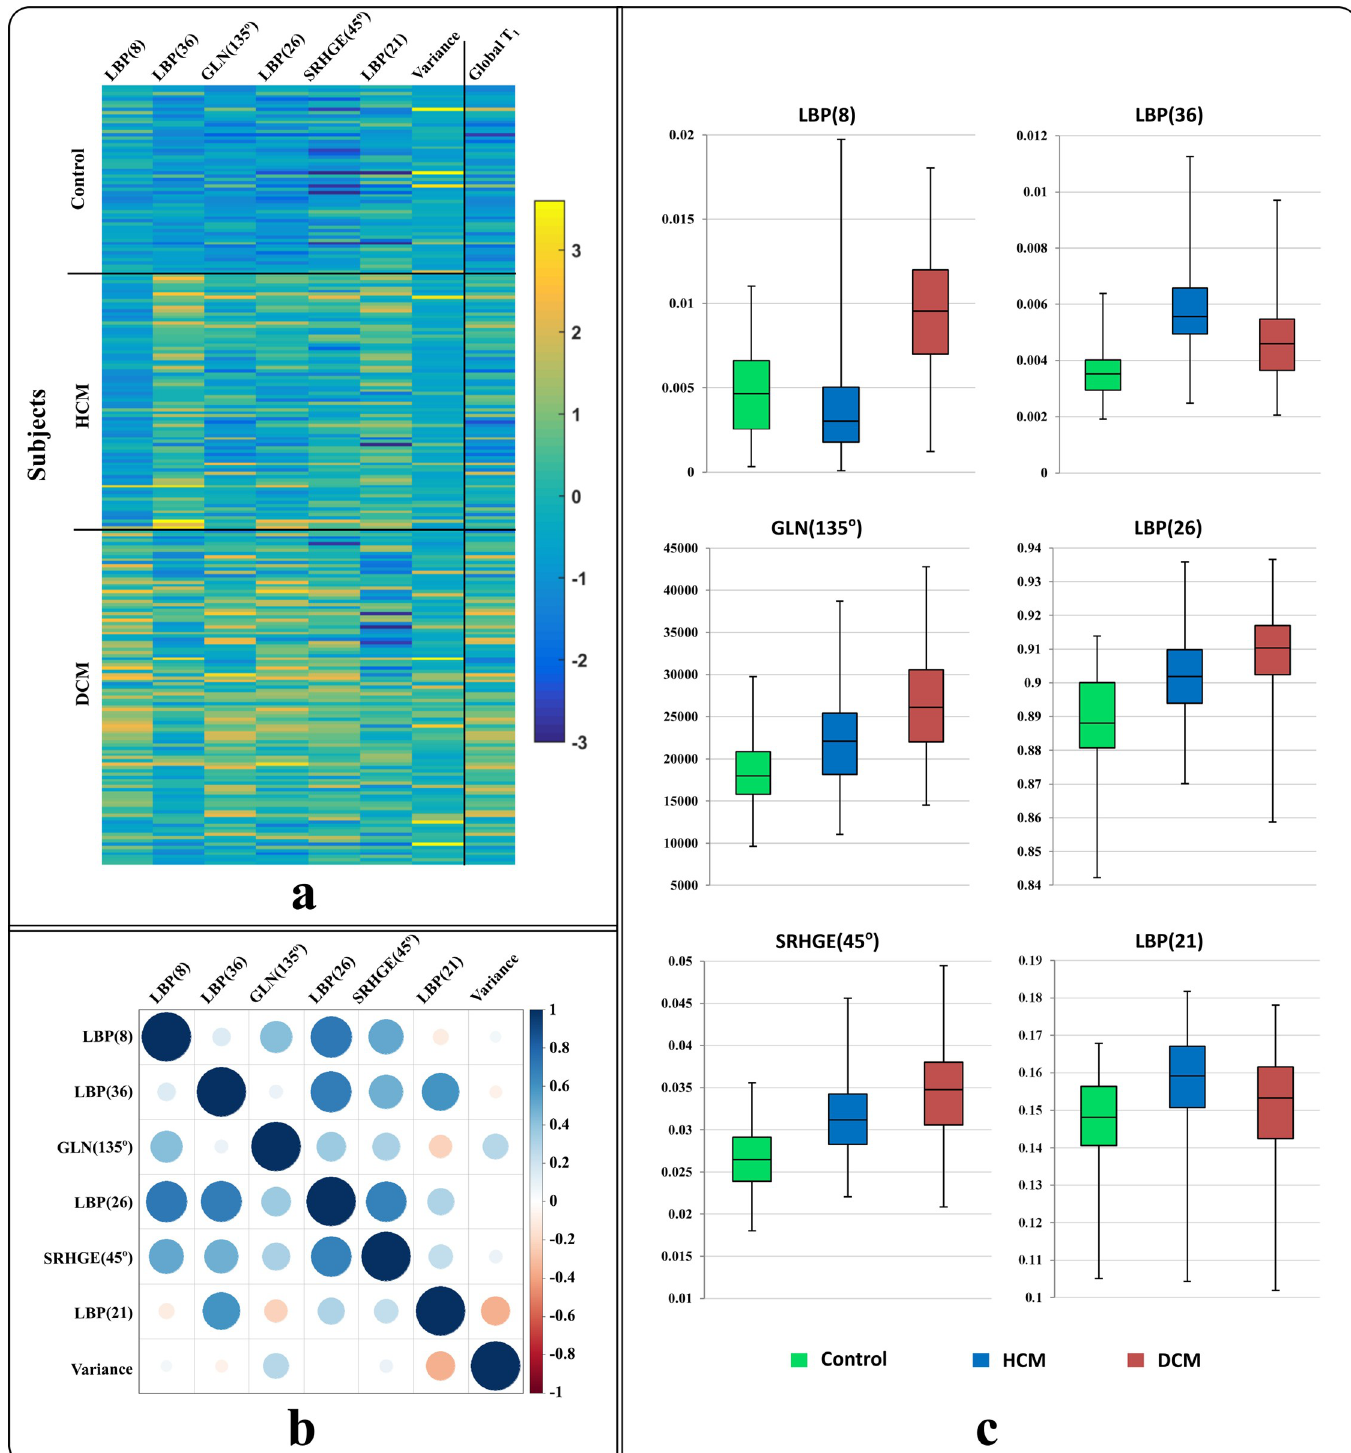
Fig 3. Texture features analysis. (a) Visual comparison of the 7 selected texture features and global native T 1 . Each row represents the feature value for an individual patient. (b) Correlation analysis of the selected texture features. Smaller/lighter-shaded circles indicate lower correlation compared to larger/darker circles. Most of the features have low correlation (i.e. hold independent information). (c) Box-and-whisker plots for the 6 most effective texture features that differentiate disease-specific patterns among 3 cohorts.